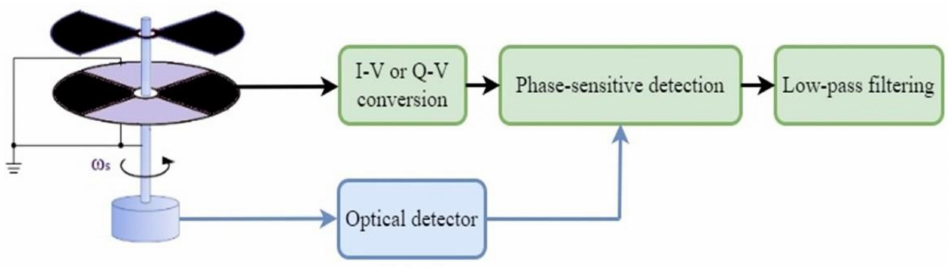
Figure 2. Typical field mill sensor interface—single-ended